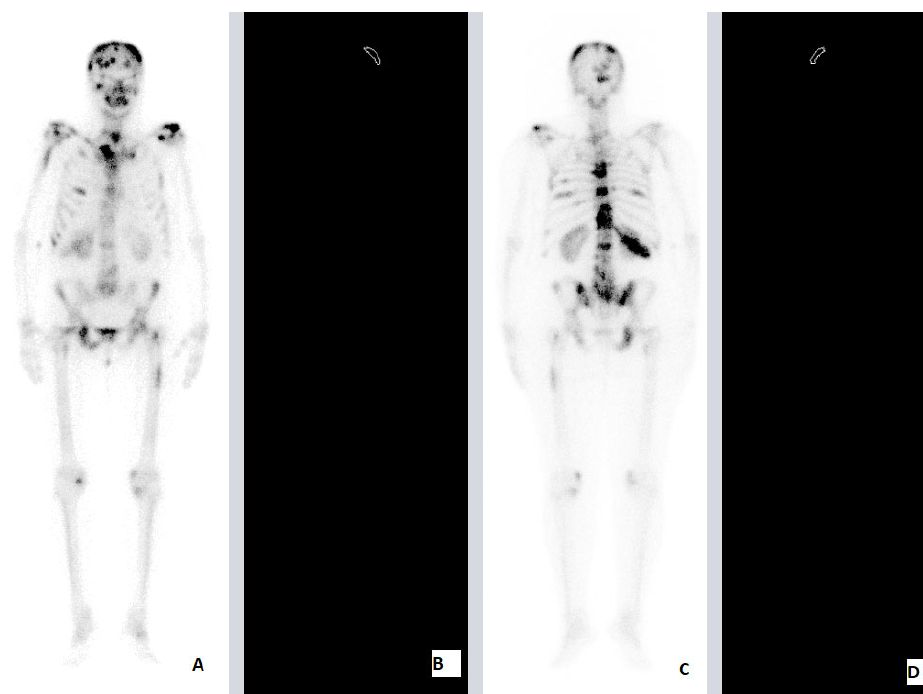
Figure 2. Female breast cancer patients with RT sites that were thoracic and lumbar vertebrae. Note the metastasis on the skull case. ( A ) Bone scintigraphy, anterior; ( B ) Dascis software, anterior, ROI on skull; ( C ) bone scintigraphy, posterior; ( D ) Dascis software, posterior, ROI on skull.